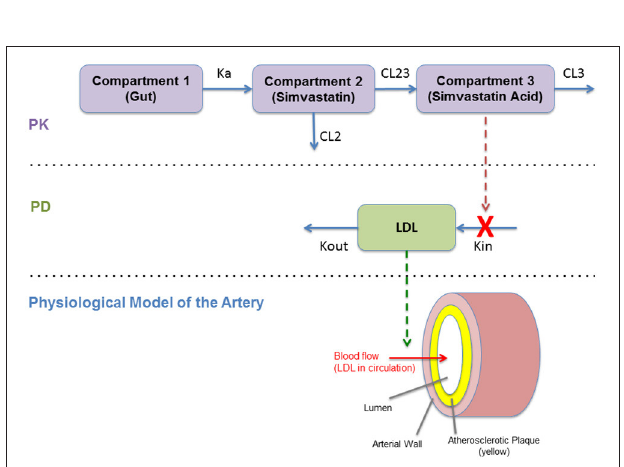
FIGURE 4 | Diagram of the pharmacokinetics/pharmacodynamics (PKPD) model (Kim et al., 2011).